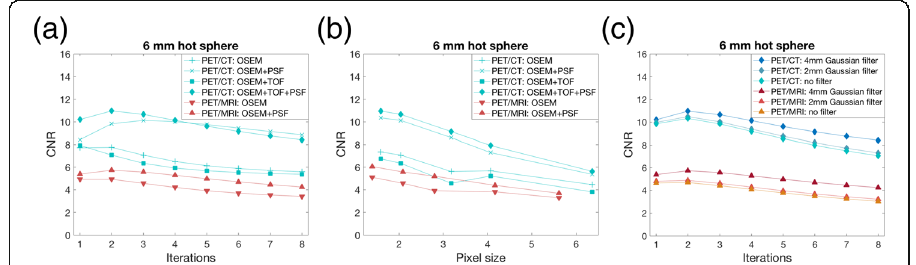
Fig. 4 Contrast-to-noise ratios (CNRs) for the PET/CT and PET/MRI systems, for a increasing number of iterations (pixel size ~2mm) and b increasing transaxial pixel sizes (3 iterations), and c CNR vs iterations for different filter settings (PET/